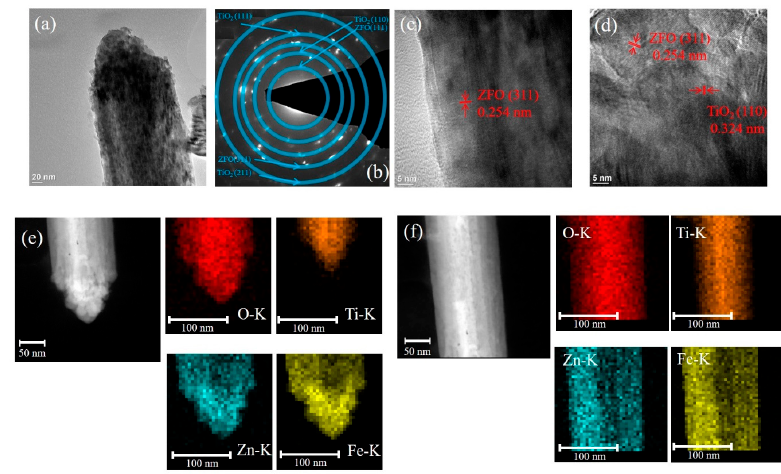
Figure 3. TEM analyses of TiO 2 –ZFO-2 nanorods: ( a ) low-magnification TEM micrograph of the single nanorod; ( b ) SAED pattern; ( c – d ) HRTEM images taken from the lateral and head regions of the nanorod, respectively; ( e ) Zn, Fe, Ti, and O mapping micrographs in head region of the nanorod; ( f ) Zn, Fe, Ti, and O mapping micrographs in the lateral region of the nanorod.